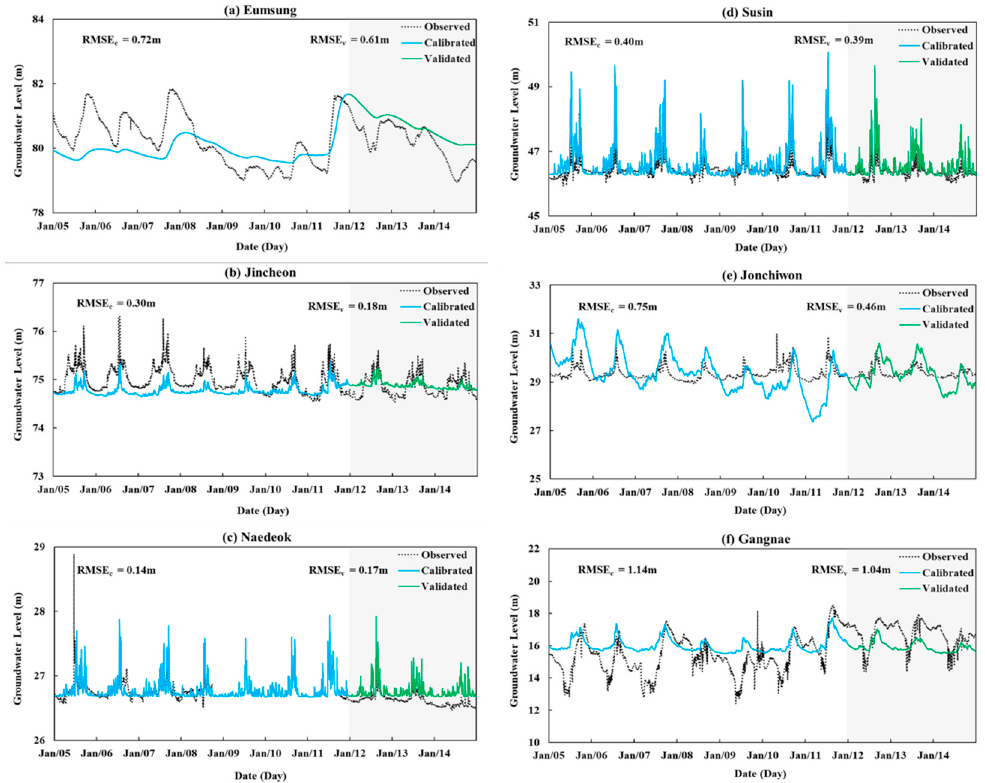
Figure 5. Comparison of the simulated and observed daily groundwater heads during the calibration (2005–2011) and validation (2012–2014) periods. RMSE c and RMSE v are the root-mean-squared errors between the daily measured groundwater heads and corresponding simulated heads during the calibration and validation periods, respectively. When calculating the RMSE c for the Naedeok well, the period from 2008 to 2011 was excluded because the groundwater head was not observed during this period.